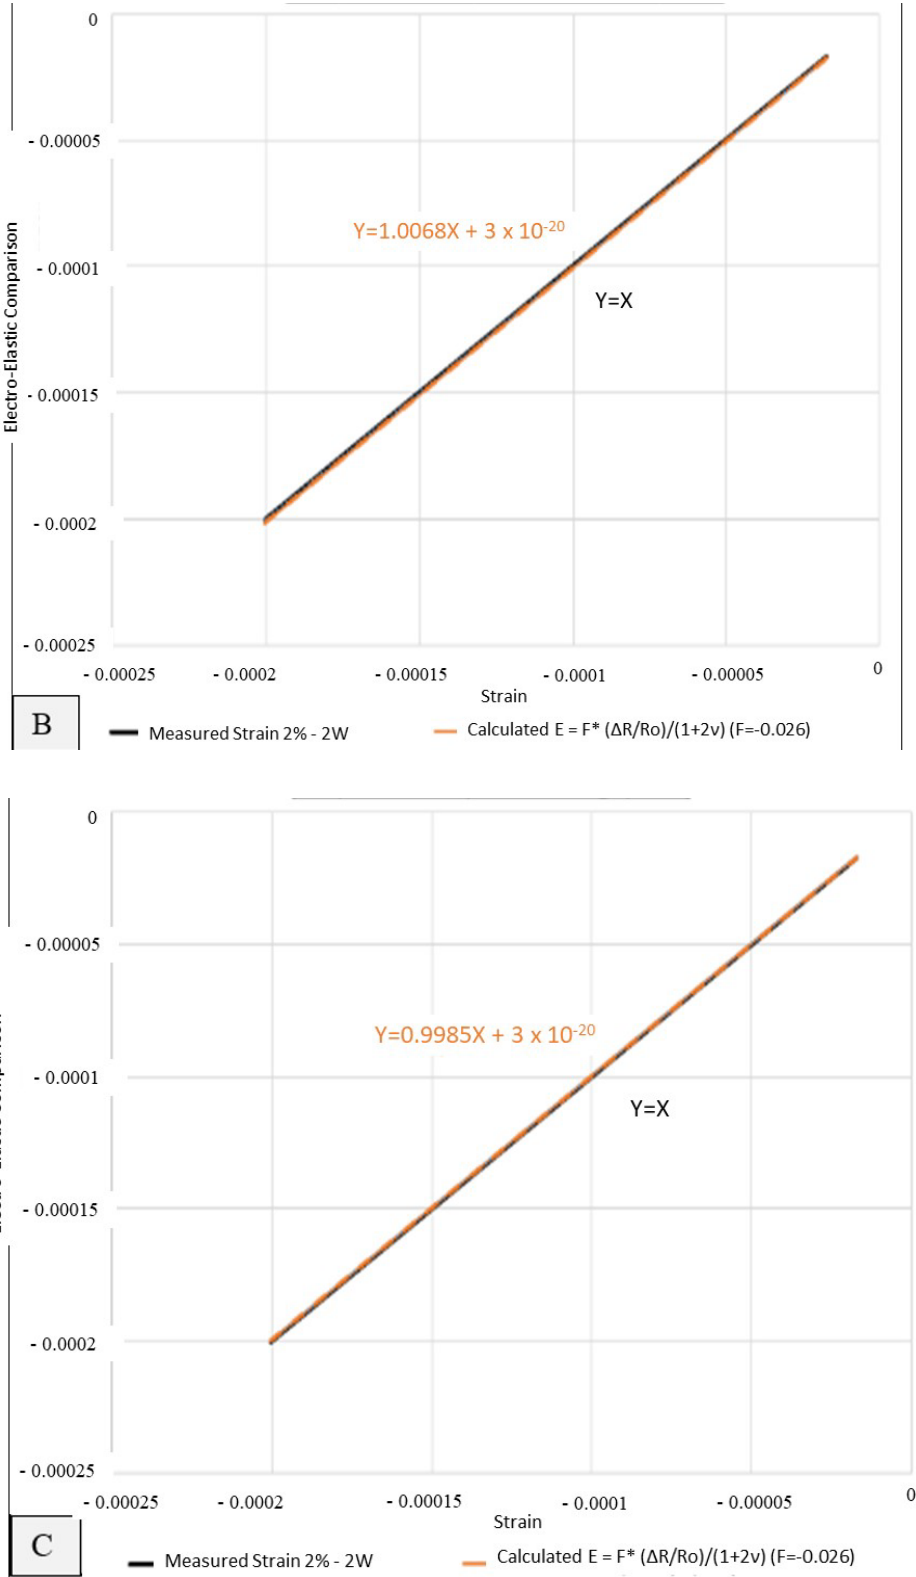
Figure 12. Design Elasto-Electric Relations for Load Test 2 of Left Electrode ( A ), Middle Electrode ( B ), and Right Electrode ( C ) Pairs.